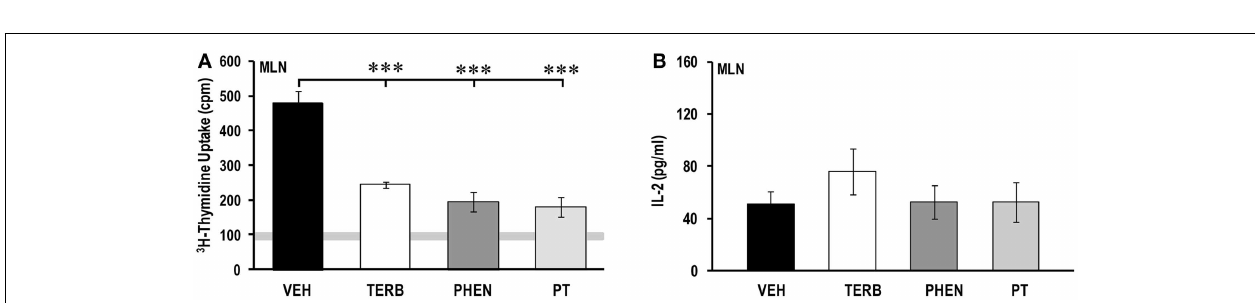
FIGURE 7 | Cytokine production by draining lymph node (DLN) cells after 24h of culture . Animals were treated with twice-daily i.p. injections of vehicle (VEH, black bars), terbutaline (TERB, white bars), phentolamine (PHEN, dark gray bars), or phentolamine and terbutaline (PT, light gray bars) initiated 12days after adjuvant challenge. (A) IL-4 production was augmented